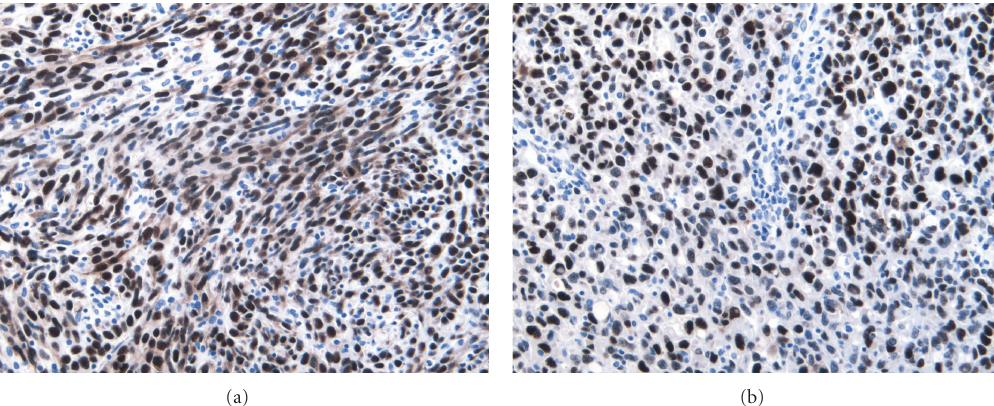
Figure 5: Representative immunohistochemical result for HHV-8, showing moderately intense nuclear staining with a granular pattern for both (a) the spindle and (b) epithelioid cells. (original magnification × 20)